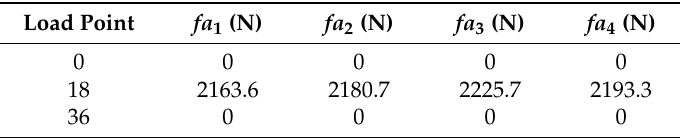
Table 5. Output value of generalized force in the Z-direction.